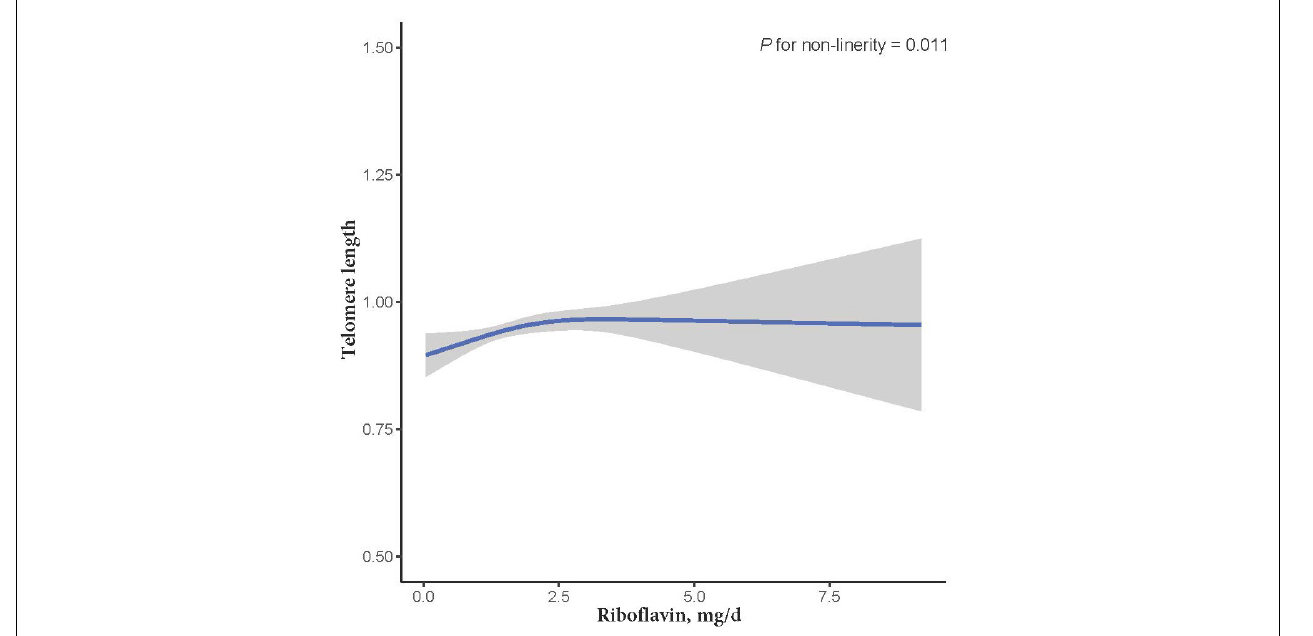
FIGURE 2 | The dose-response relationship between dietary riboflavin intake and telomere length. Point estimates (solid line) and 95% confidence intervals (dashed lines) were estimated by restricted cubic splines analysis with knots placed at the 5th, 50th, and 95th percentile (minimum as the reference).